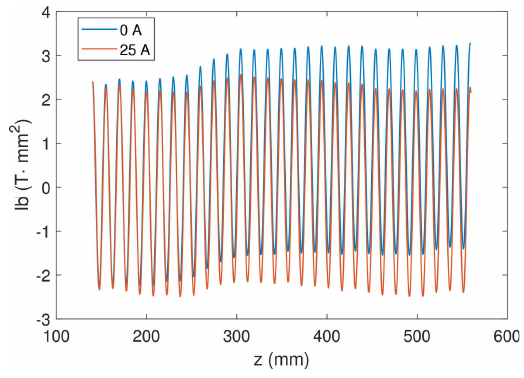
Figure 15 The first integral of the middle part of the magnetic field at 450 A main current with 0 A and 25 A correction current.